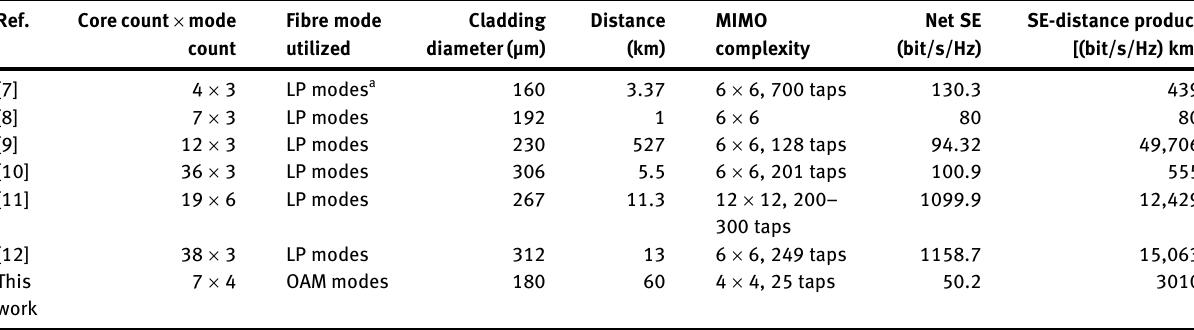
Table  : Comparisonofthereportedtransmissionsystemsbasedonmulti-corefew-mode fi bres.Allmodecountsshouldbemultipliedby  to include the two polarization modes.